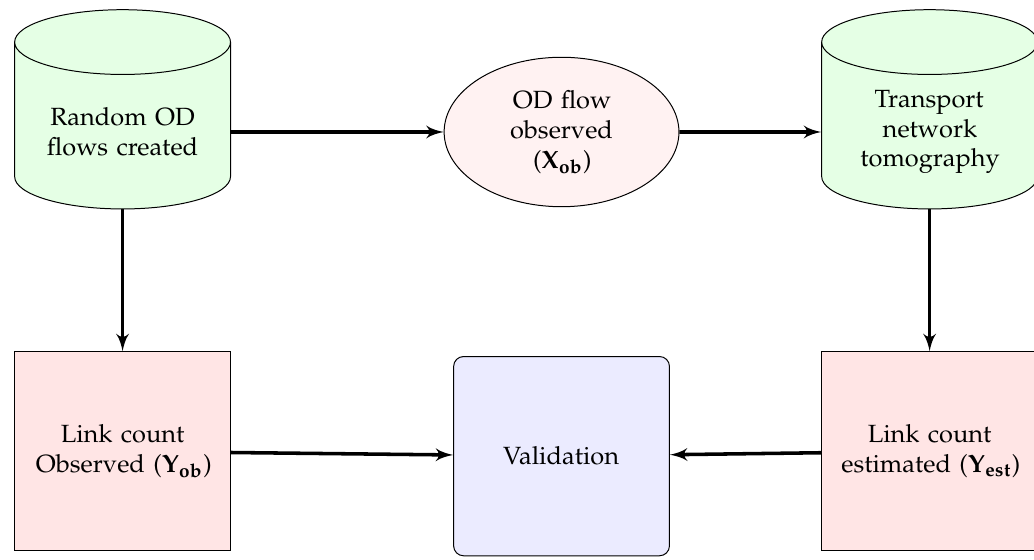
Figure 9. Validation technique for link count using real-world random